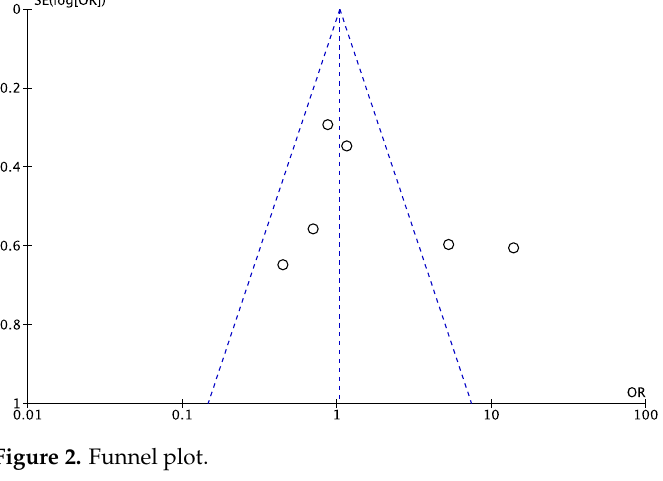
Figure 2. Funnel plot.